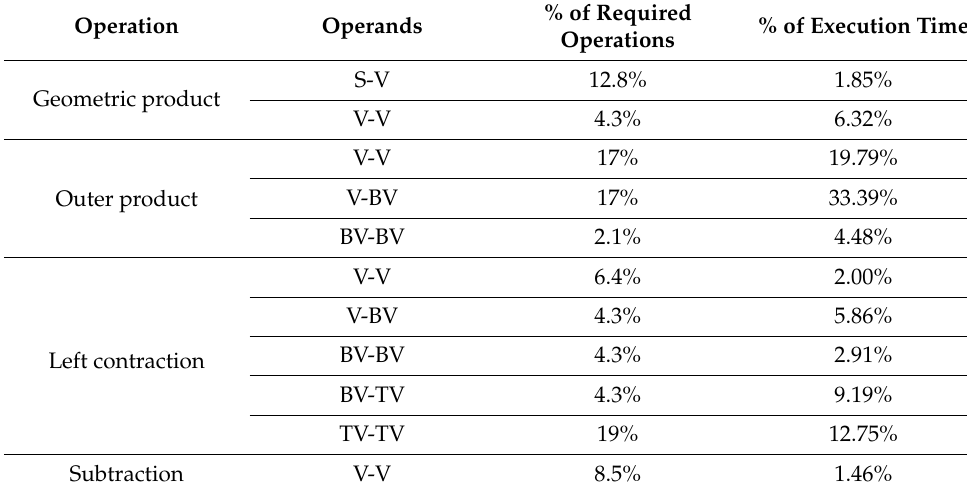
Table 10. Inverse kinematics algorithm profiling.